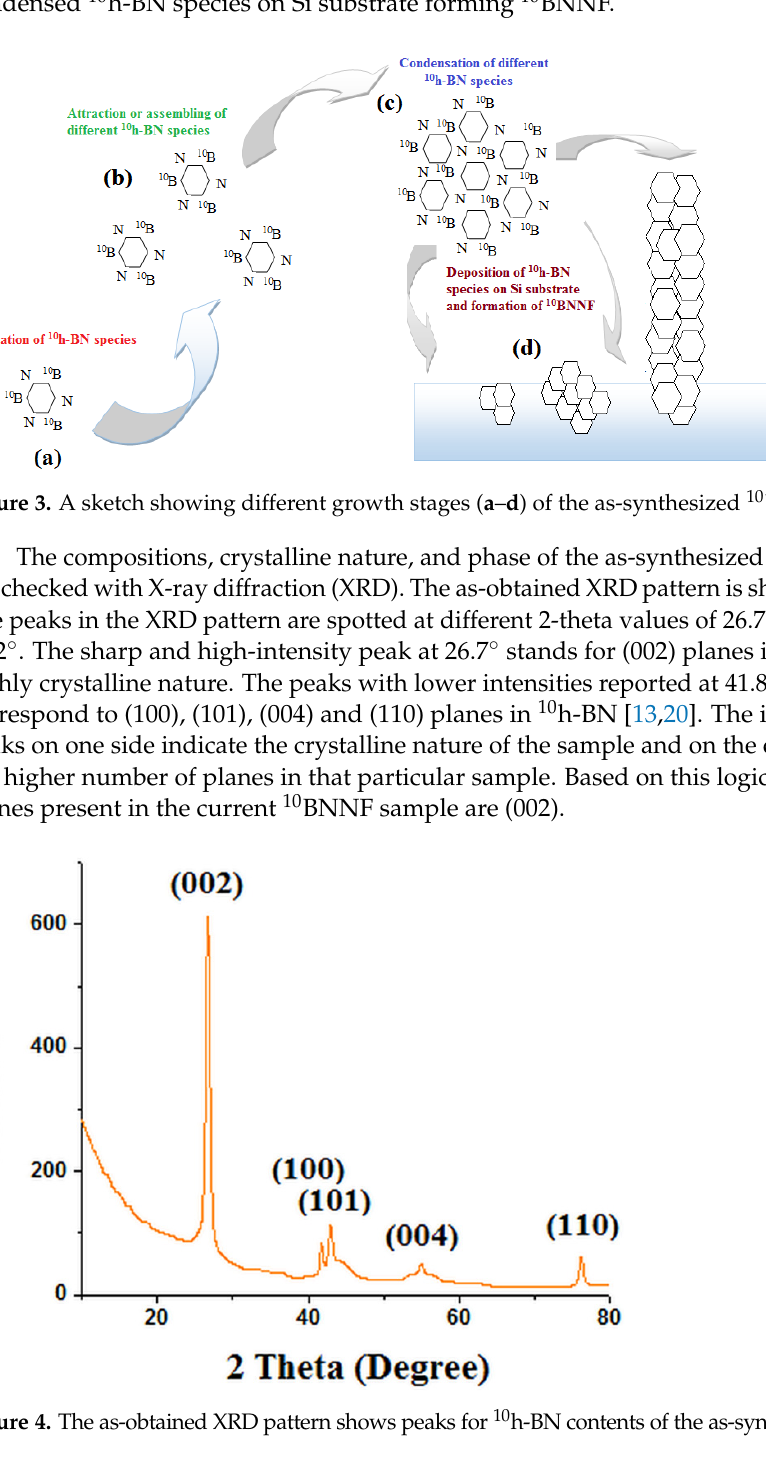
Figure 4. The as-obtained XRD pattern shows peaks for 10 h-BN contents of the as-synthesized 10